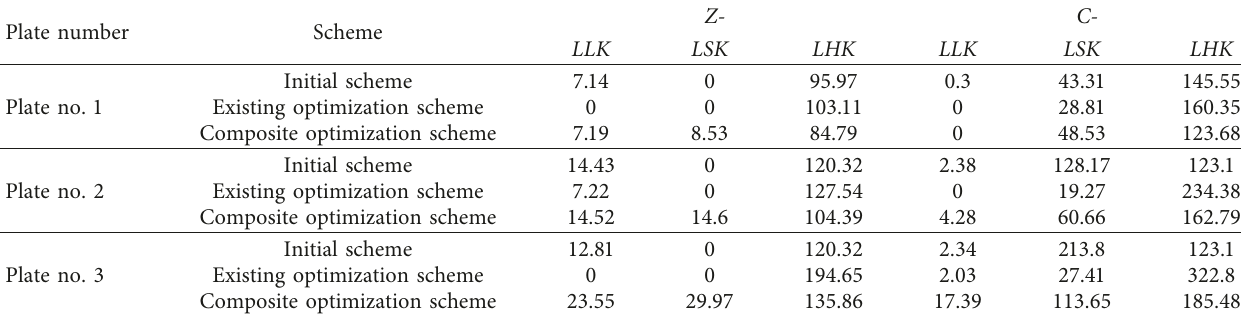
Table 7: Comparison of the number of keel types and the comprehensive calculation length of each scheme (units: × 10 3 mm). Plate number